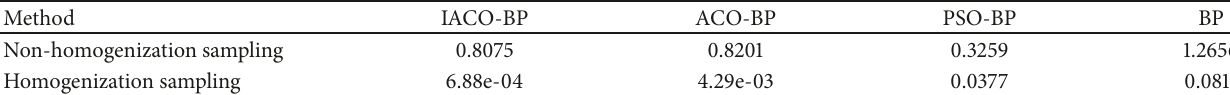
Table 3: Precision